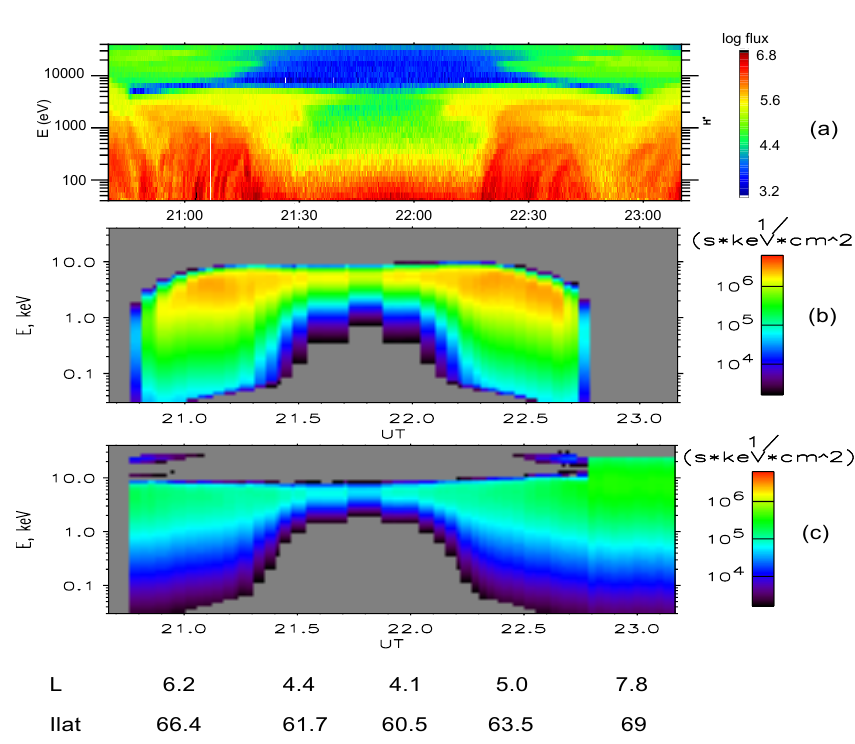
Fig. 11. Same as Fig. 10 but for the 21 November 2001 event.